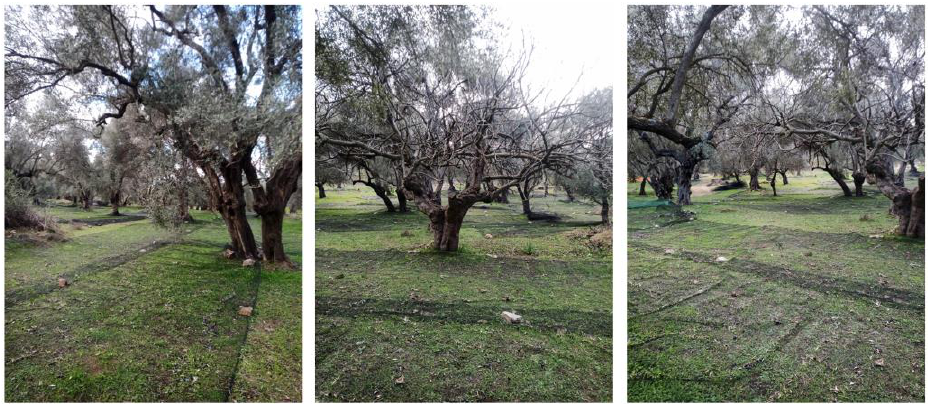
Figure 1. Olive-harvesting nets under the canopy of the olive trees, in a traditional olive grove on the island of Lesvos.